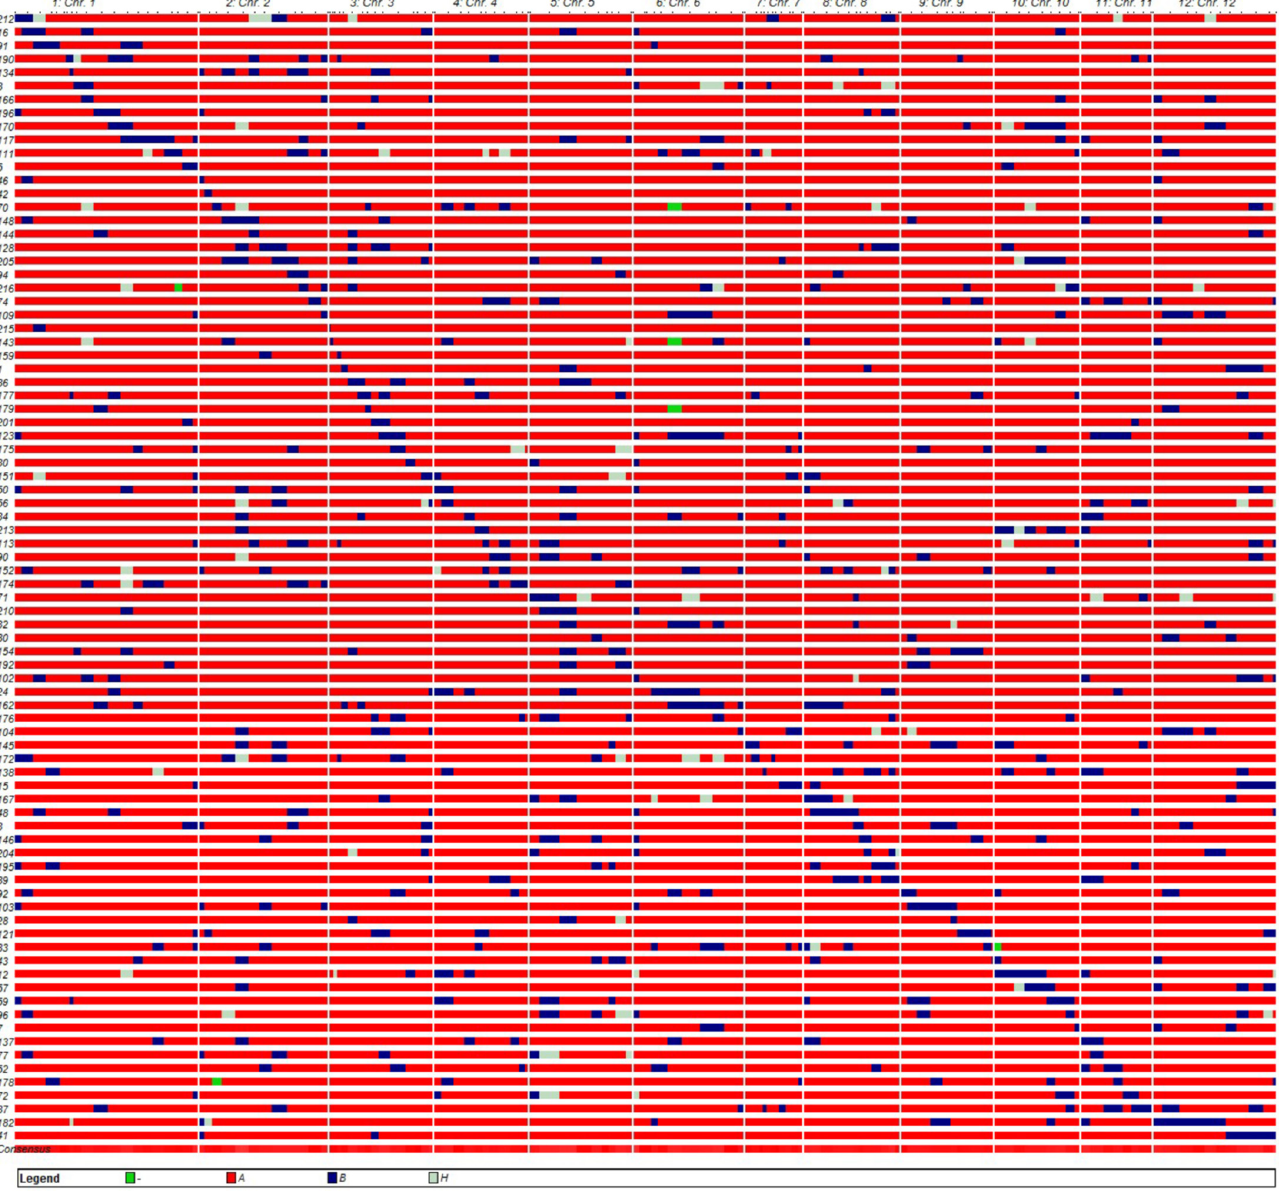
Figure 1. A graphical representation of the genotypes of the chromosome segment substitution line (CSSL) population. Regions with red, blue, and gray backgrounds indicate homozygous segments from the recurrent parent R974, the donor parent DXWR, and the two parents, respectively. The green regions indicate missing segments. Each row represents a single CSSL.